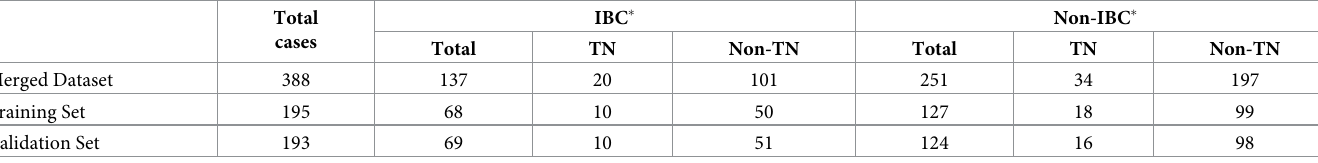
Table 1. Final merged dataset and training and validation sets.